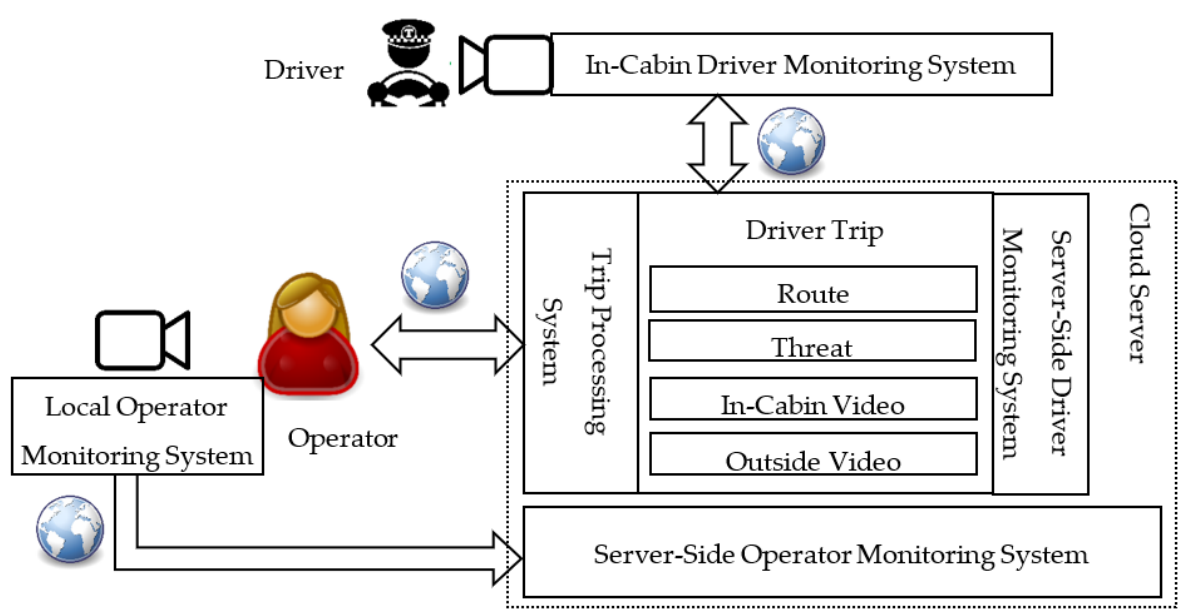
Figure 1. General scheme of the driver and operator interaction in the driver monitoring system.